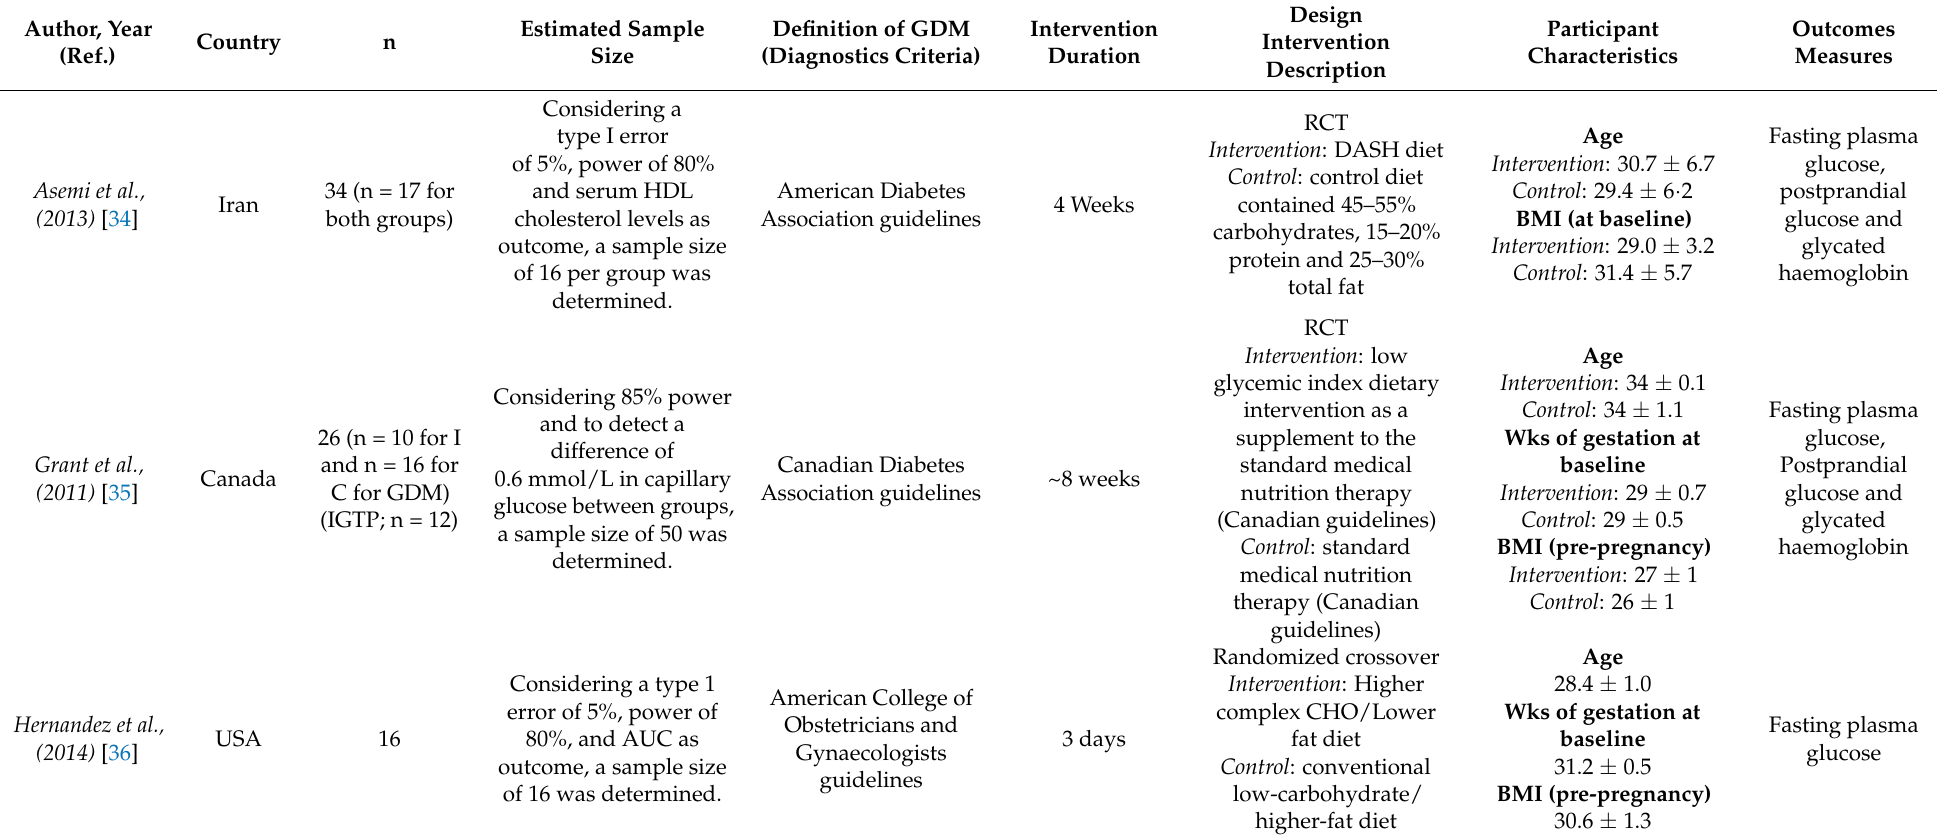
Table 2. Summary of RCTs and crossover studies investigating effect of diet-based interventions on glycemic indices in